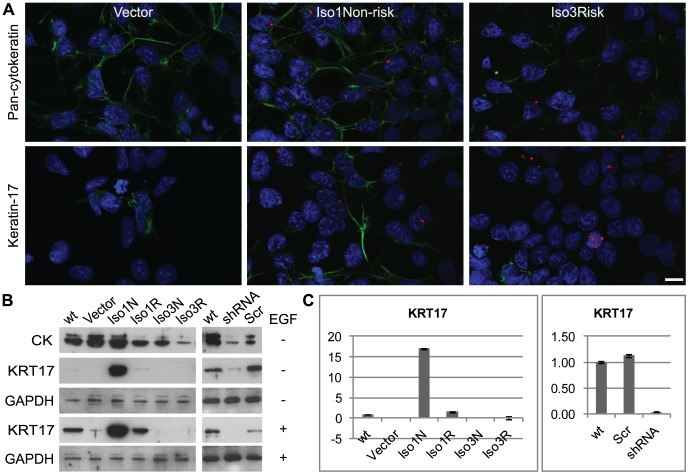
CCHCR1 affects the expression of cytokeratins.(A, B) The overall expression of cytokeratins is reduced especially in the Iso3Risk (Iso3R) overexpressing cells shown by (A) immunofluorescence staining (here presented vector control, Iso1Non-risk (Iso1N) and Iso3Risk (Iso3R) cells) and (B) Western blotting with pan-cytokeratin (CK) antibody (green). The KRT17 expression is increased in the Iso1Non-risk cells (green). The up-regulation of KRT17 is shown by (A) immunofluorescence (here presented vector control, Iso1Non-risk and Iso3Risk cells), (B) Western Blotting and (C) qPCR. (B) EGF stimulates KRT17 expression in all the other, except the isoform 3-expressing cells. The silencing of CCHCR1 in HEK293 cells (shRNA) downregulates KRT17 expression, shown by (B) Western blotting and (C) qPCR. (B) The expression of KRT17 under CCHCR1 silencing is not restored by EGF stimulation. (B) Also the overall expression of cytokeratins is decreased in CCHCR1 silenced HEK293 cells demonstrated with pan-cytokeratin (CK) antibody. Wt, non-transfected HEK293 cells; shRNA, HEK293 cells transfected with CCHCR1-shRNA construct; Scr, HEK293 transfected with the scrambled sequence. Staining with an antibody for GAPDH was used to control sample loading on SDS-PAGEs. DAPI stained nuclei are shown in blue. Scale bar 10 µm.